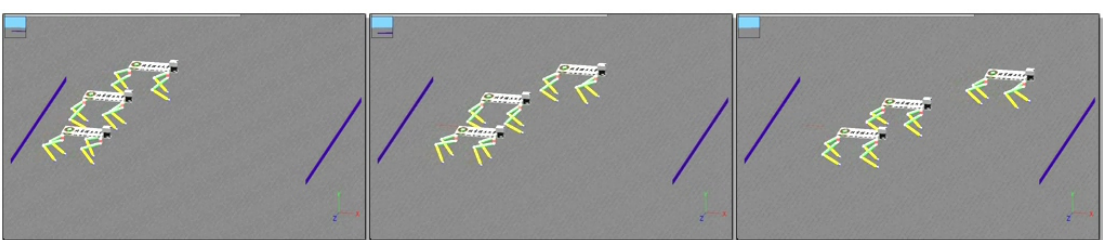
Figure 8. Simulations of quadruped robot walking with three static